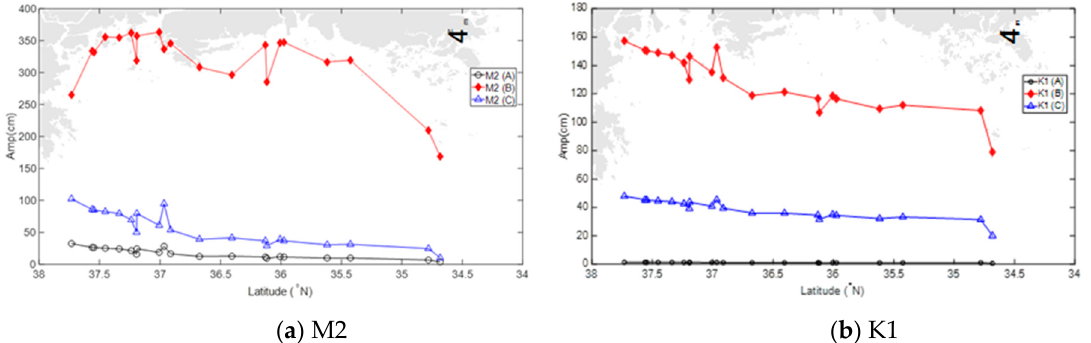
Figure 10. Computed amplitudes at gauge locations with respect to the assumed forcing with an amplitude of 100 cm at each open boundaries A, B and C; ( a ): M2’s amplitude; ( b ): M2’s amplitude.